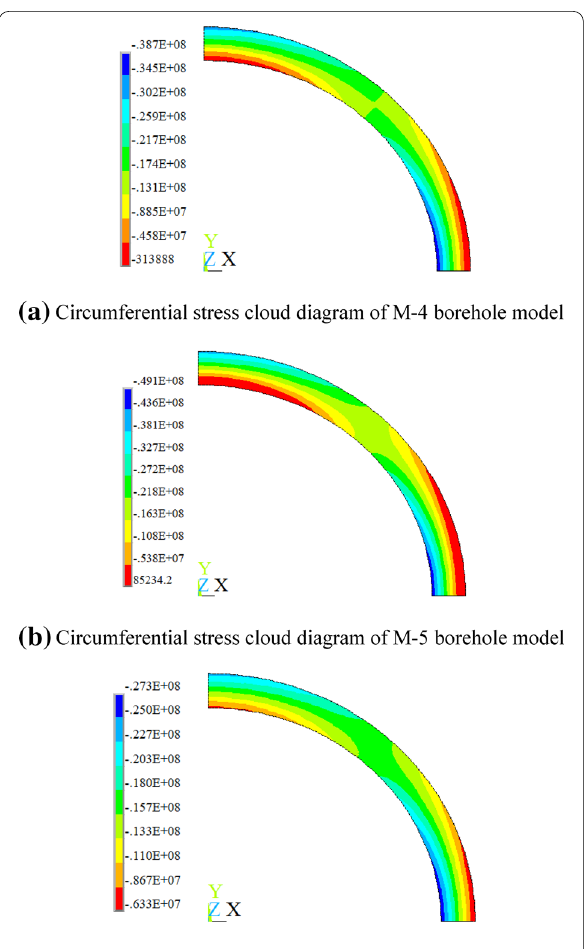
Fig. 5 Circumferential stresses of different borehole wall models when λ =